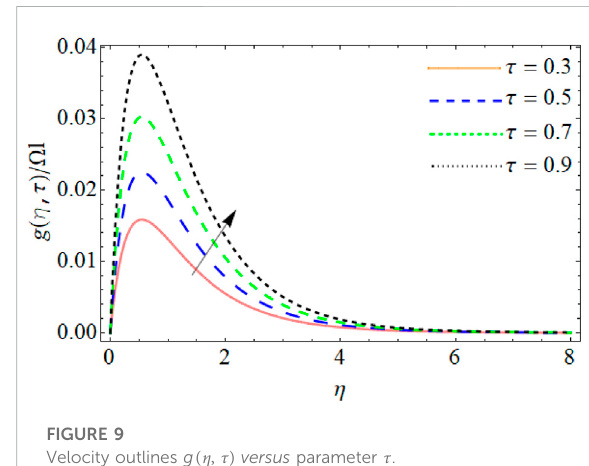
FIGURE 9 Velocity outlines g ( η , τ ) versus parameter τ .